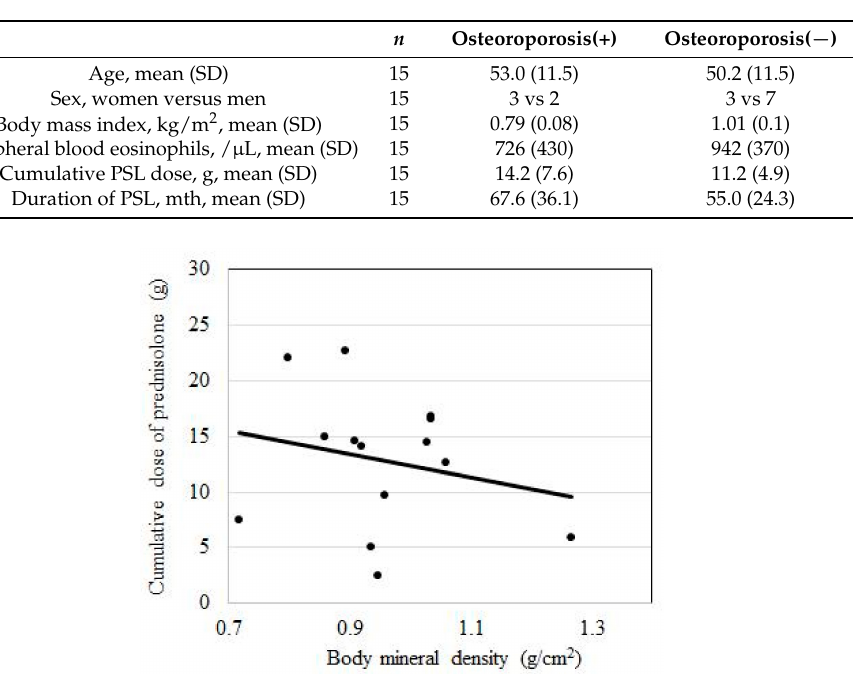
Table 2. Risk factors of osteoporosis.